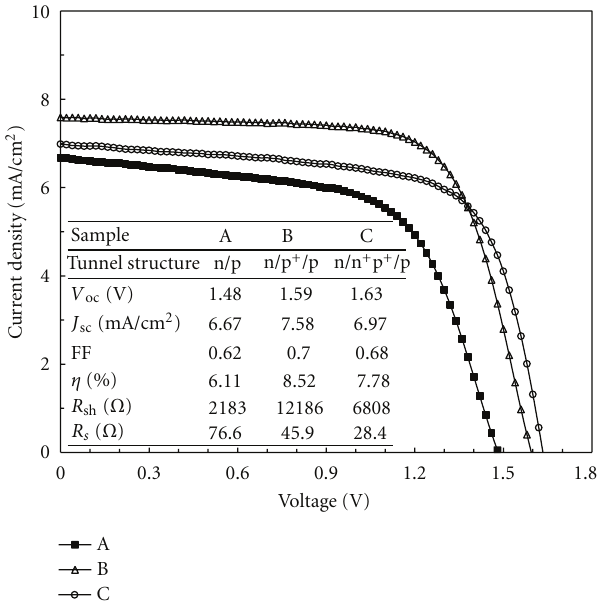
Figure 2: I-V characteristics of sample A, B, and C. Sample A is with the standard n/p junction; sample B has the p + recombination layer; sample C has the n + /p + double recombination layer.